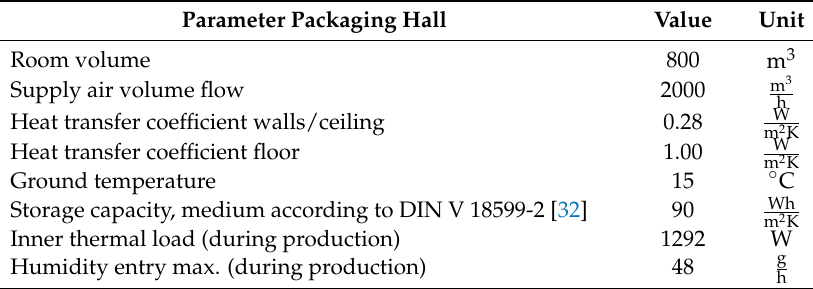
Table 1. Important key parameters of the modeled packaging